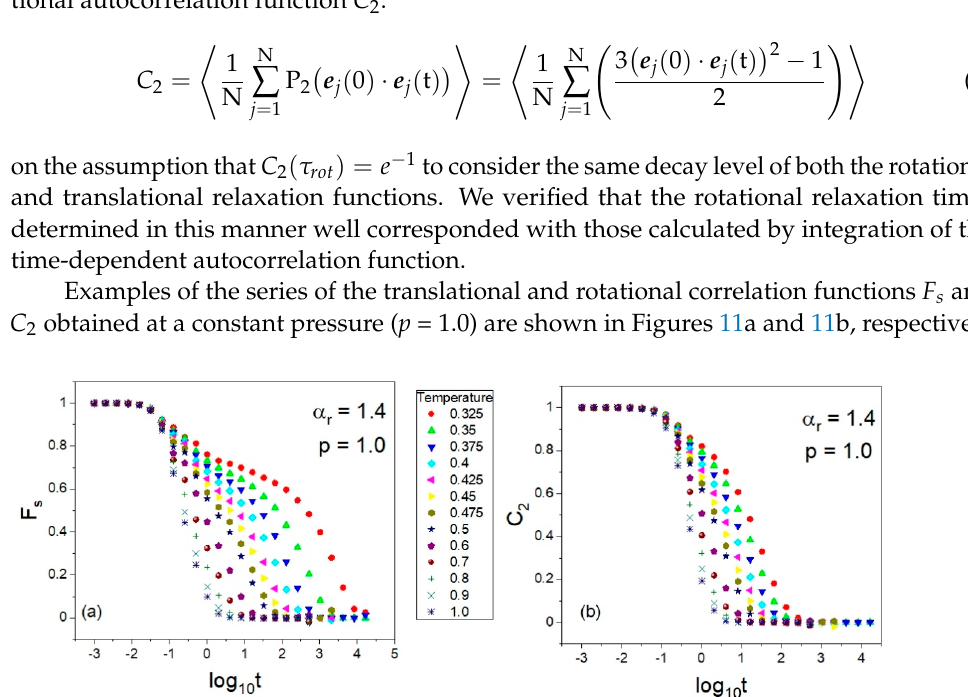
Figure 11. Examples of the translational ( a ) and rotational ( b ) time-dependent autocorrelation functions C 2 and F s obtained respectively via Equations (7) and (9) from the NPT MD simulation data collected in the supercooled liquid state at the pressure p = 1.0 in the GB model of the molecules of the aspect ratio α r =